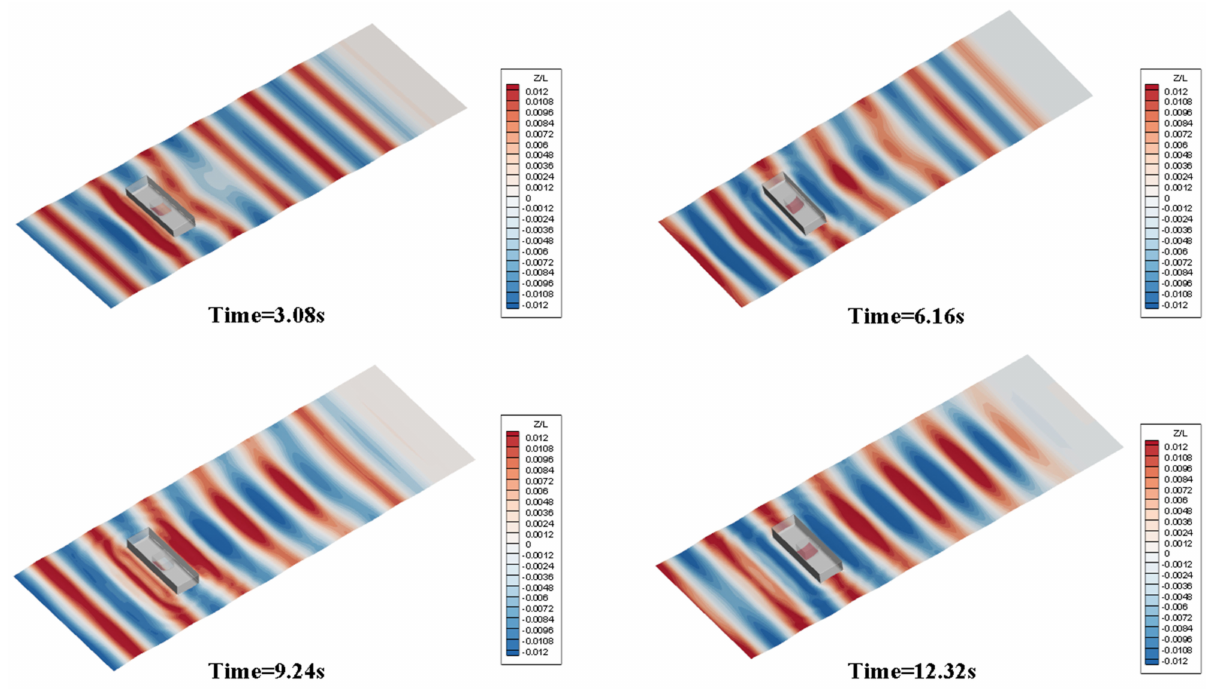
Figure 19. The wave pattern in different